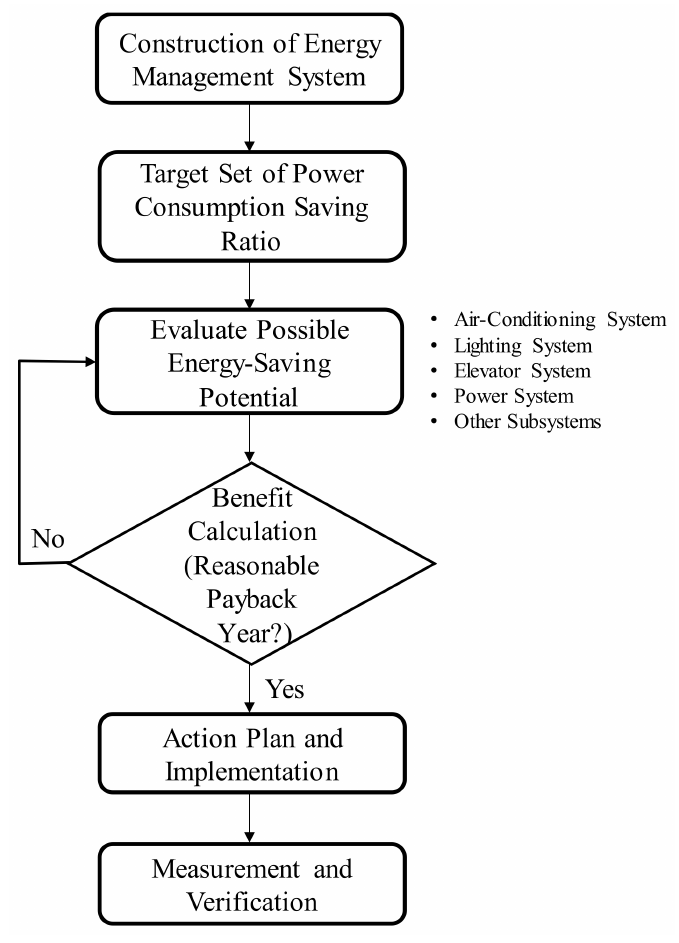
Figure 2. Systematic design of energy-saving